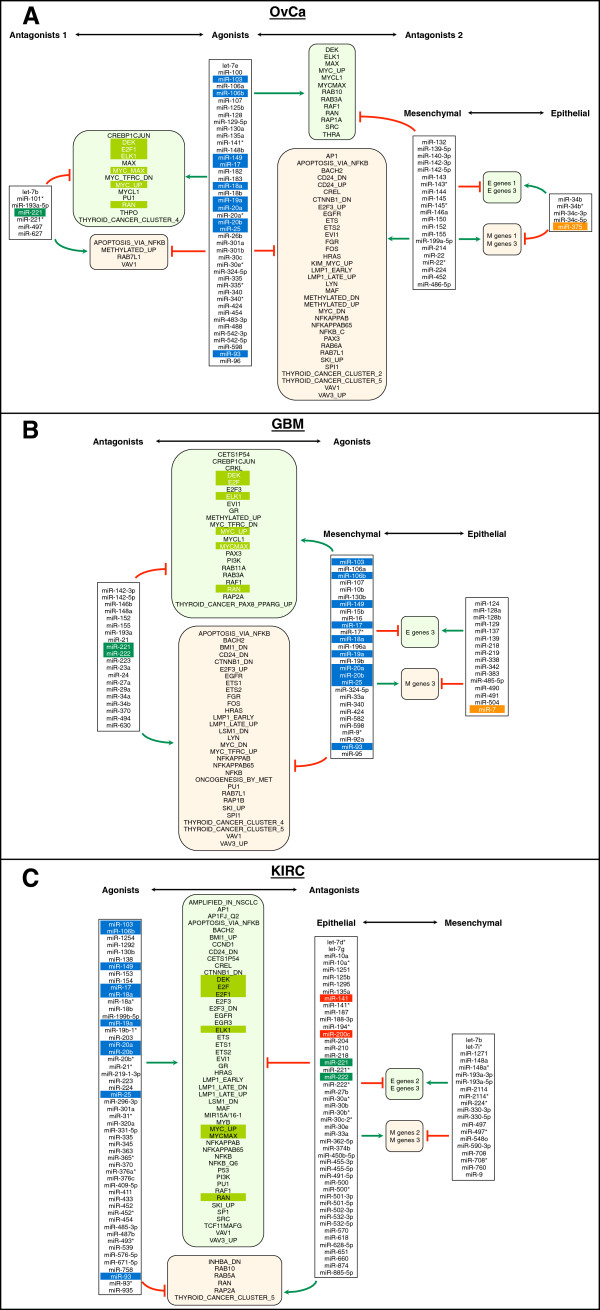
A correlation network of miRNA groups and gene signatures in three primary cancers. (A) OvCa. (B) GBM. (C) KIRC. miRNAs: blue, miR-17 family; dark green, miR-221/222 family; red, EMT-related miRNAs (miR-200 family); orange, other EMT-related miRNAs (miR-7, 203 or 375). Oncogenic and EMT signatures (in rectangular boxes with round corners): light green, positively correlating with agonistic miRNAs; light red, negatively correlating with agonistic miRNAs; oncogenic signatures highlighted with light green, overlapping signatures among three primary cancers.